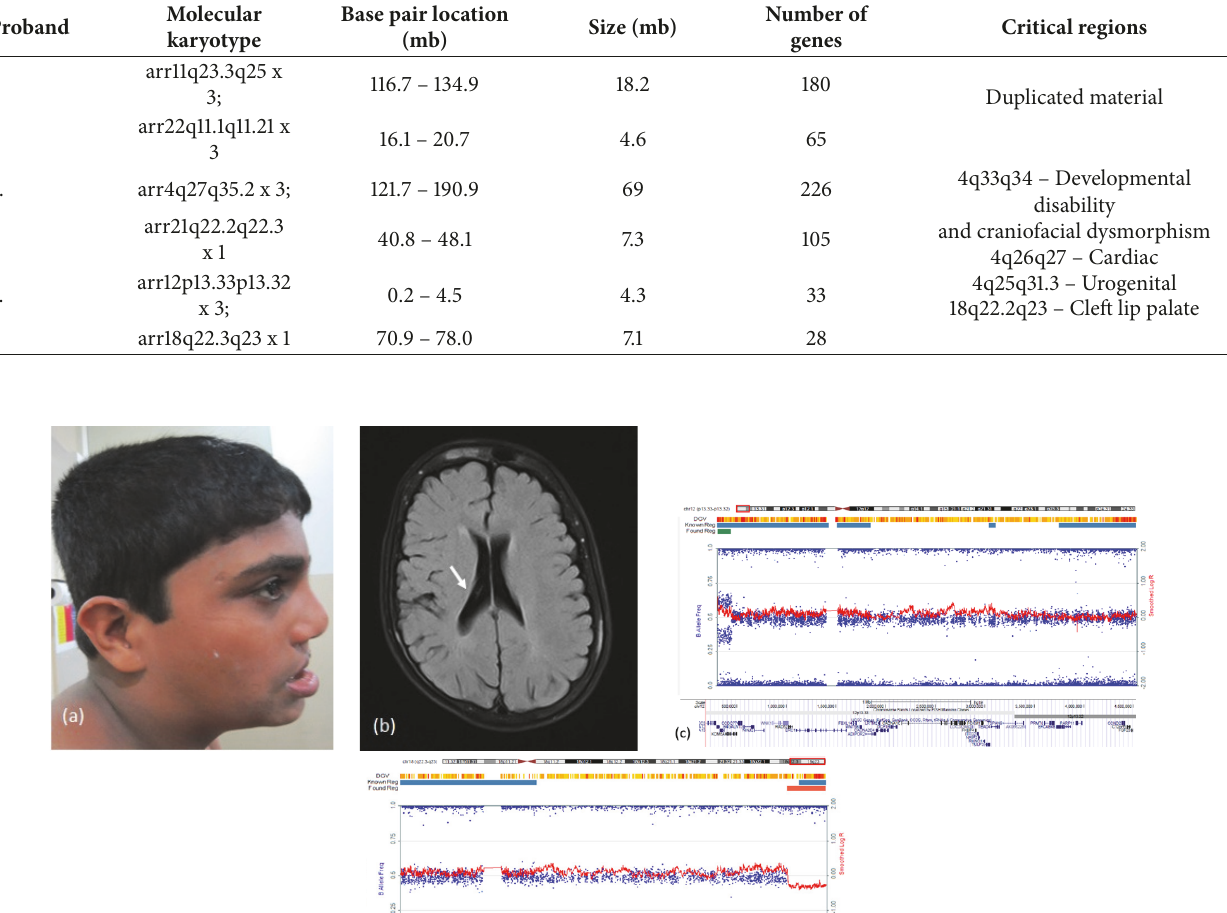
Table 1: Molecular karyotype with chromosomal base pair location, size, number of genes, and critical regions in the case series.